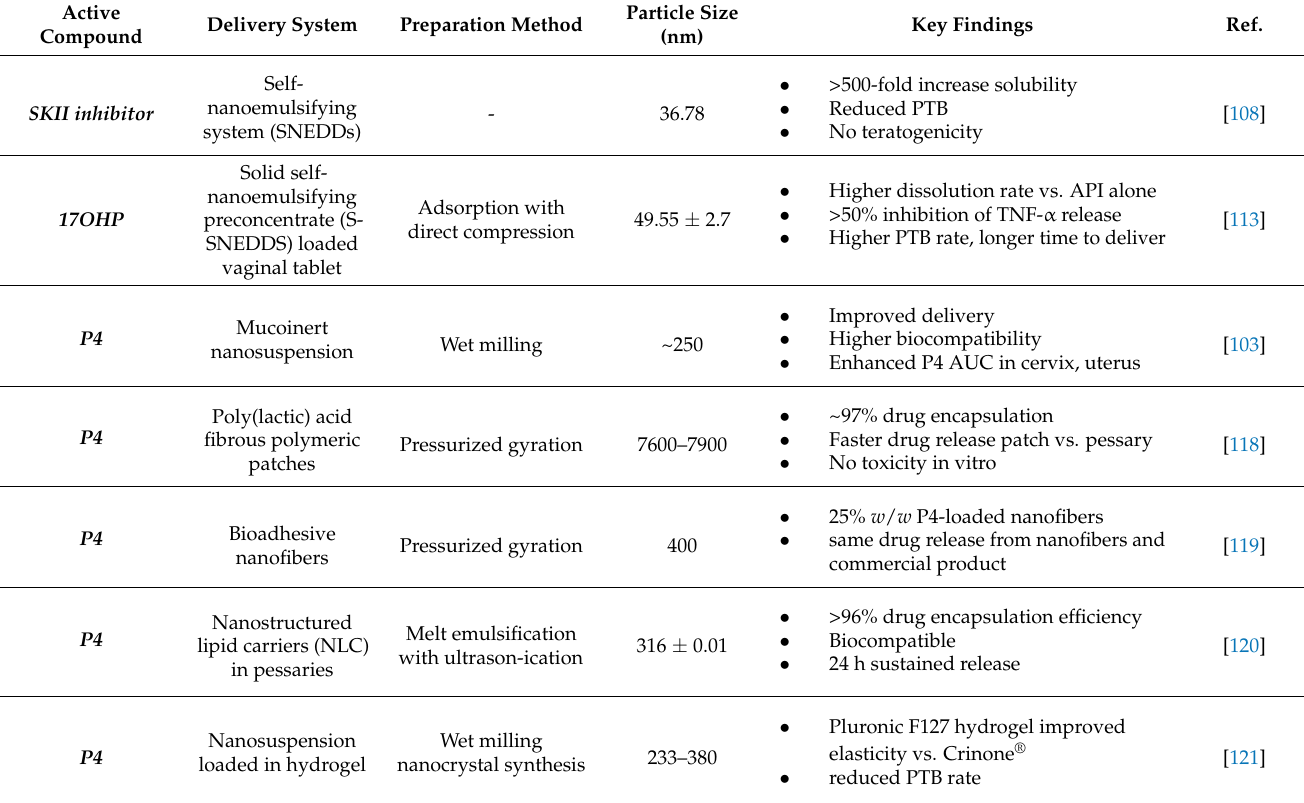
Table 1. Nanoformulations of Sphingosine Kinase II (SKII) inhibitor, 17- α hydroxyprogesterone (17OHP), and Progesterone (P4) for the prevention of